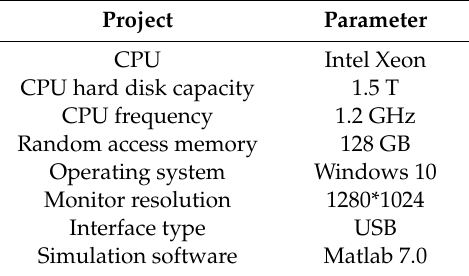
Table 1. Experimental environment settings.